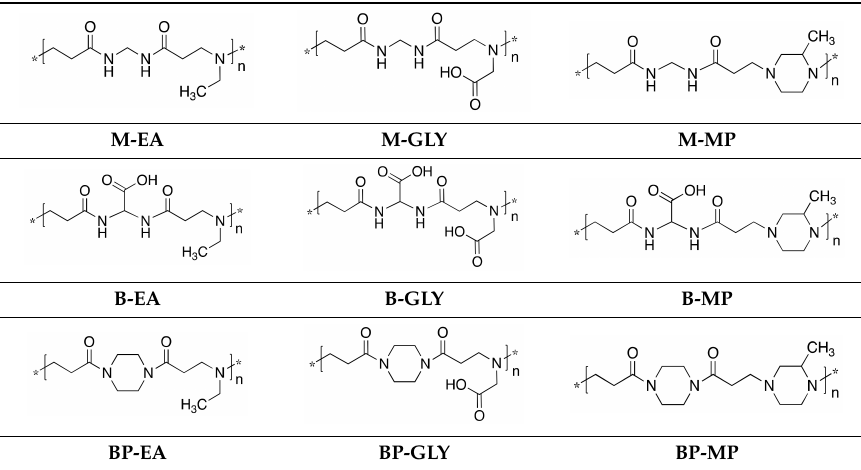
Table 3. Repeat units of the linear PAAs studied a